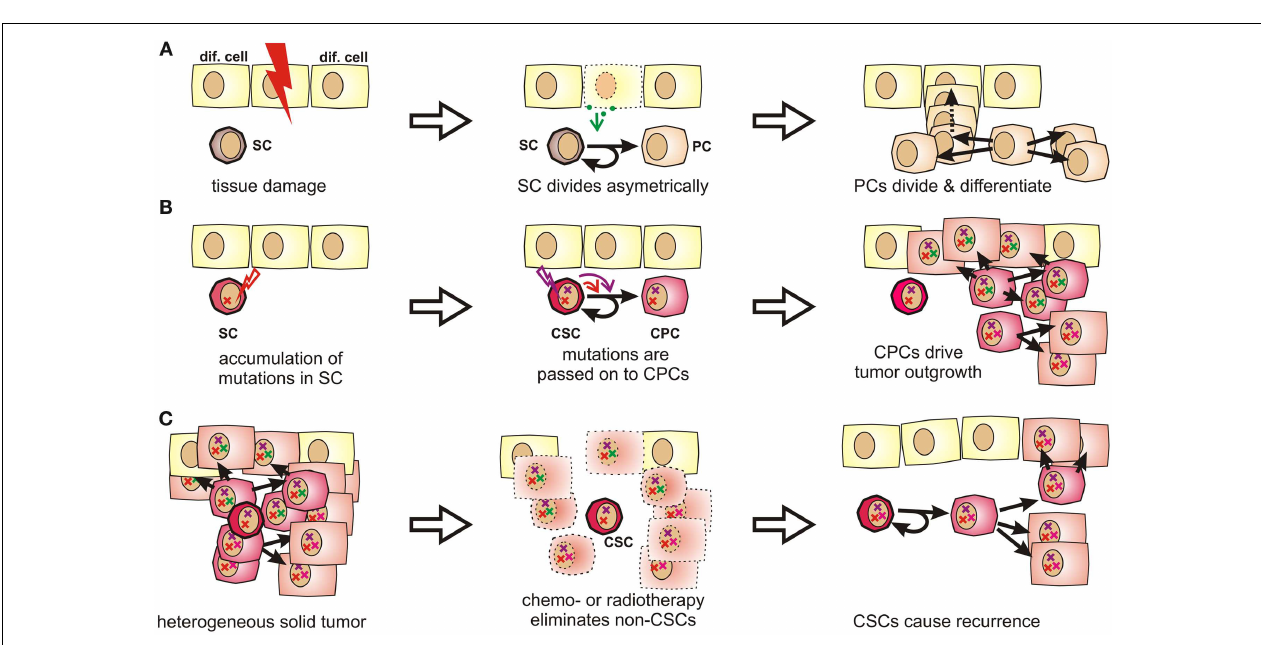
long-lived, pluripotent, and can undergo an unlimited number of cell divisions. Therefore, they may accumulate more mutations than other cells and are thus stochastically more likely to initiate a tumor.These mutations are passed on to progenitor cells, which may drive tumor outgrowth as they cycle much faster by nature. (C) Stem cells and CSCs are highly resistant to chemotherapeutic agents and irradiation, which explains why these cells might selectively survive cytoreductive therapy.Therefore, these cells may cause cancer recurrence years or decades